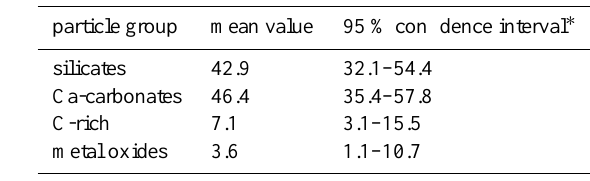
Table 3. Relative number abundance [%] of the different particle groups that acted as IN ( N =